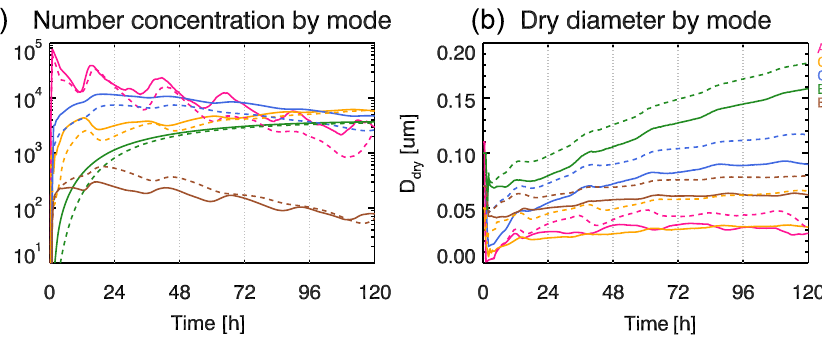
Figure 4. Number concentration (a) and dry particle diameter (b) by mode (color lines) for MATRIX (dashed lines) and MATRIX-VBS (solid lines) for the experiments with the same conditions as Fig.